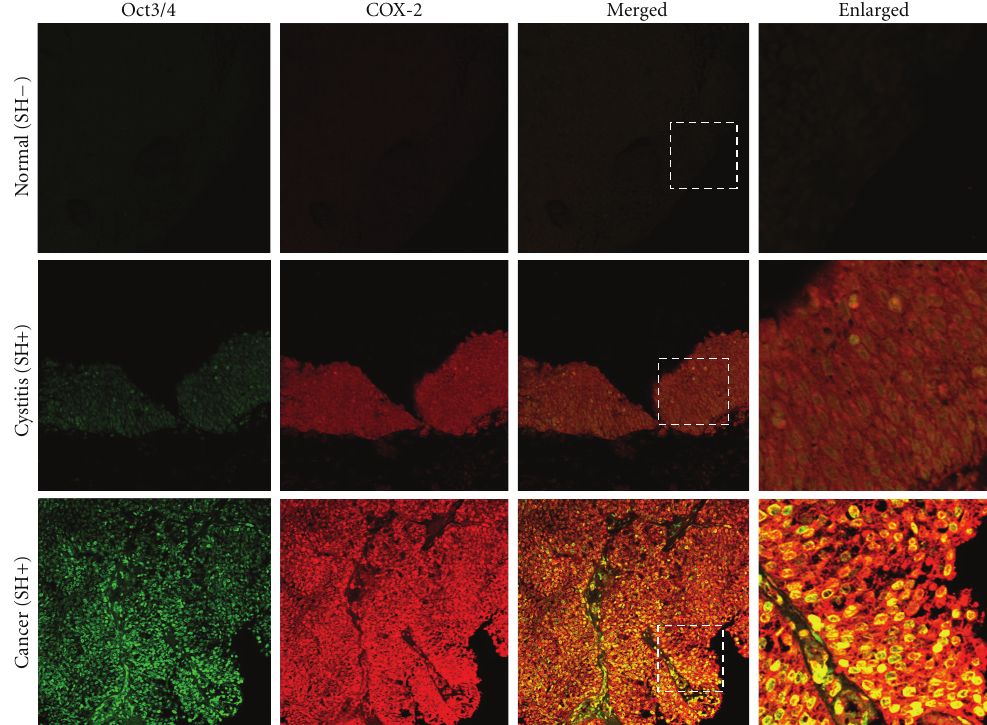
Figure 2: Colocalization of Oct3/4 and COX-2 in urinary bladder samples. The distribution of Oct3/4 (green) and COX-2 (red) was determined by double immunofluorescence in urinary bladder tissues from normal, S. haematobium -associated cystitis and cancer subjects. Original magnification is 200x. Enlarged: enlargement of dotted areas. SH: S. haematobium